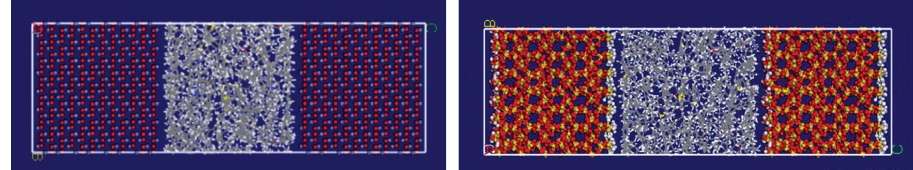
Figure 7: Termal conductivity calculation